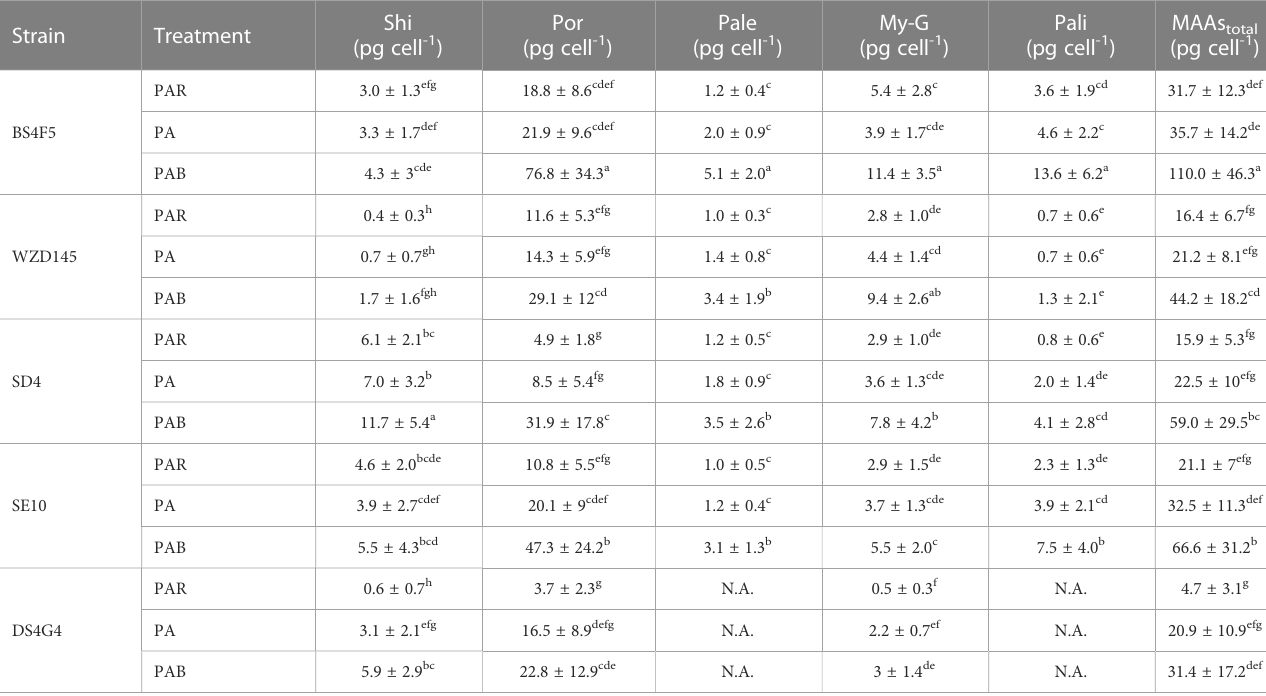
TABLE 1 The contents of mycosporine-like amino acids under different light conditions in the fi ve strains of P. lima complex and P. caipirignum (strain SE10).